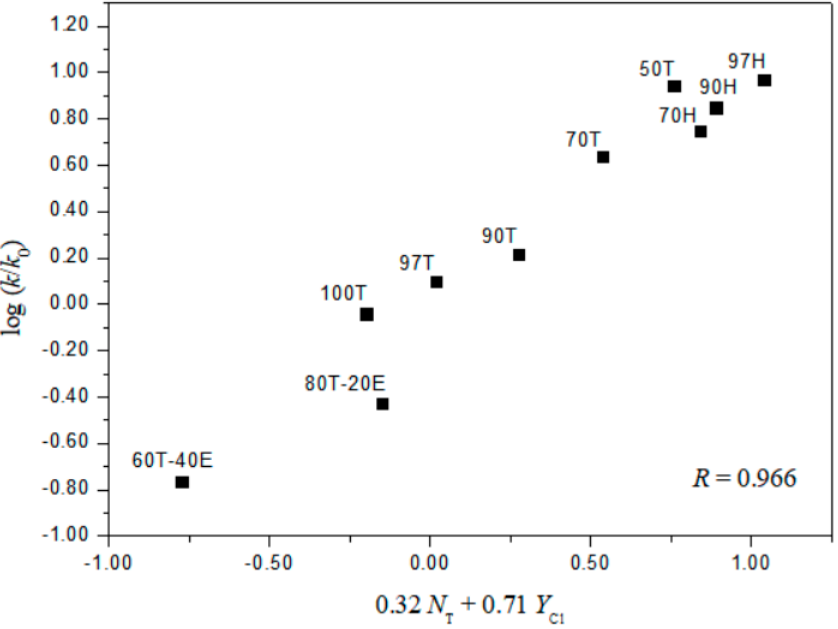
Figure 5. The plot of log ( k/k o ) o vs. 0.32 N T + 0.71 Y Cl for the solvolysis of o ‐ nitrobenzoyl chloride ( 2 ) in various fluoroalcohol solvents at 25.0 °C.